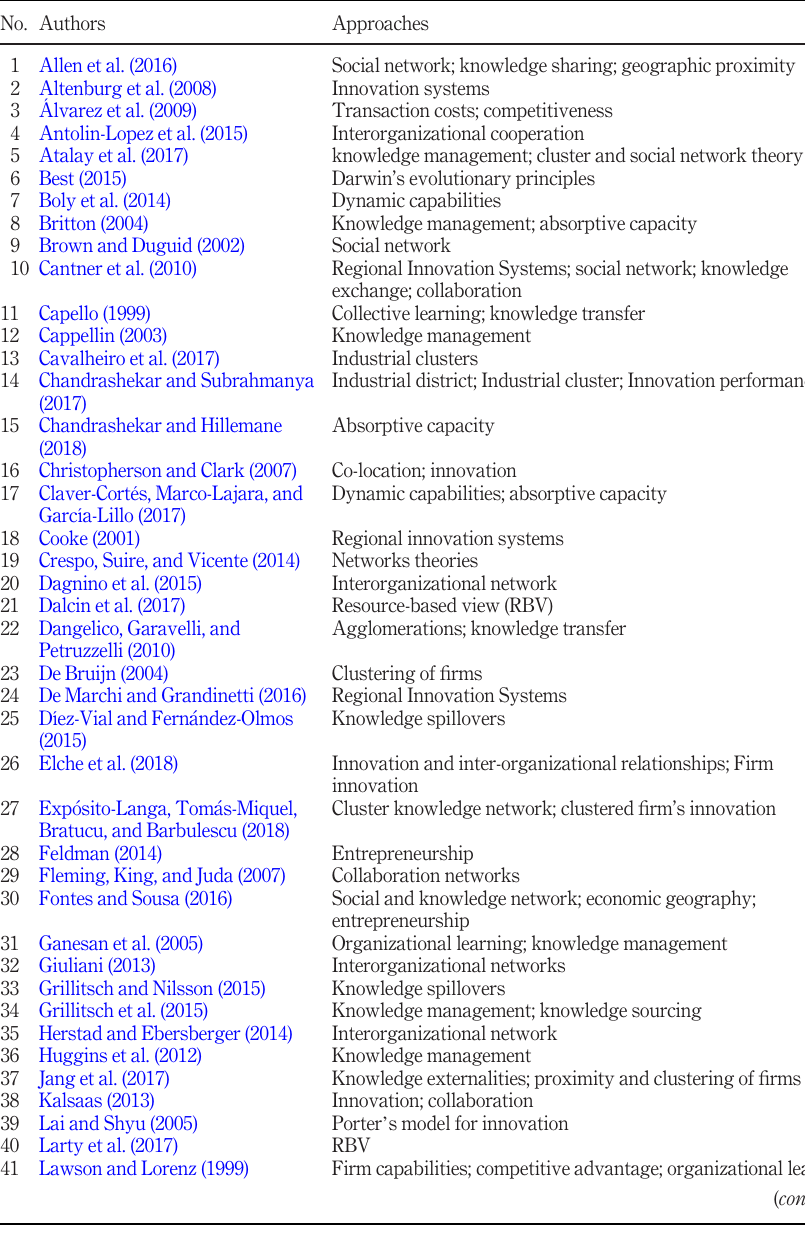
Table A1. Authors of the